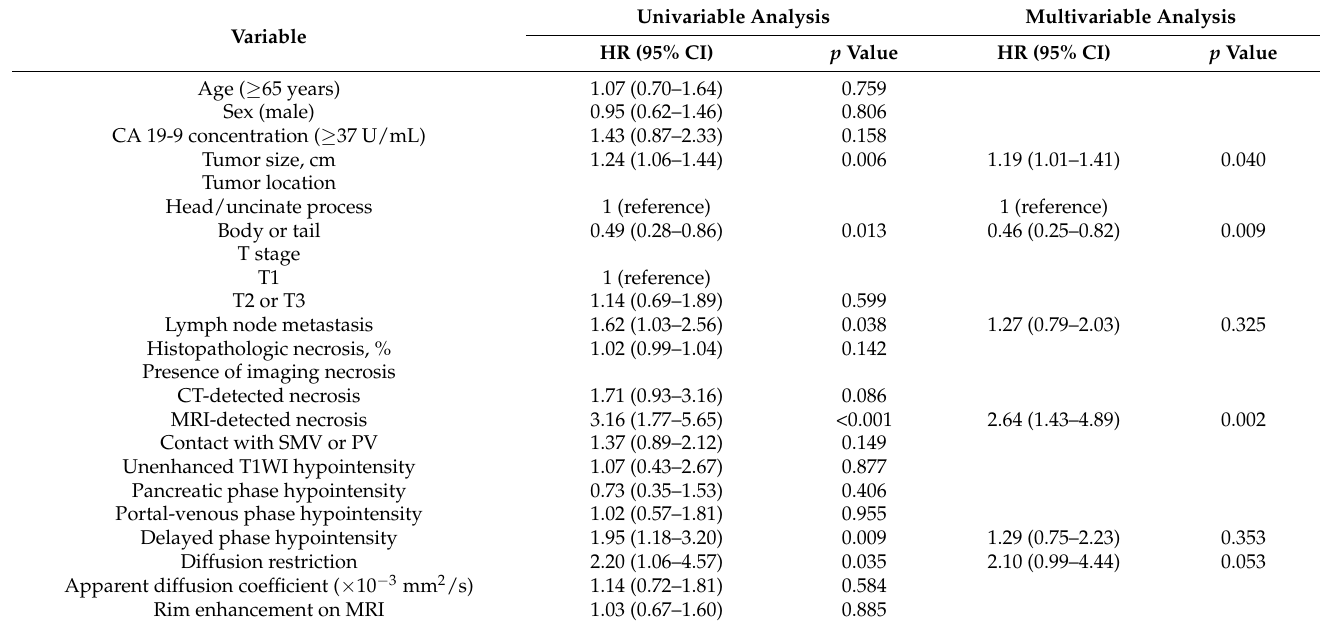
Table 3. Univariable and multivariable Cox proportional hazard analyses for disease-free survival after surgery.